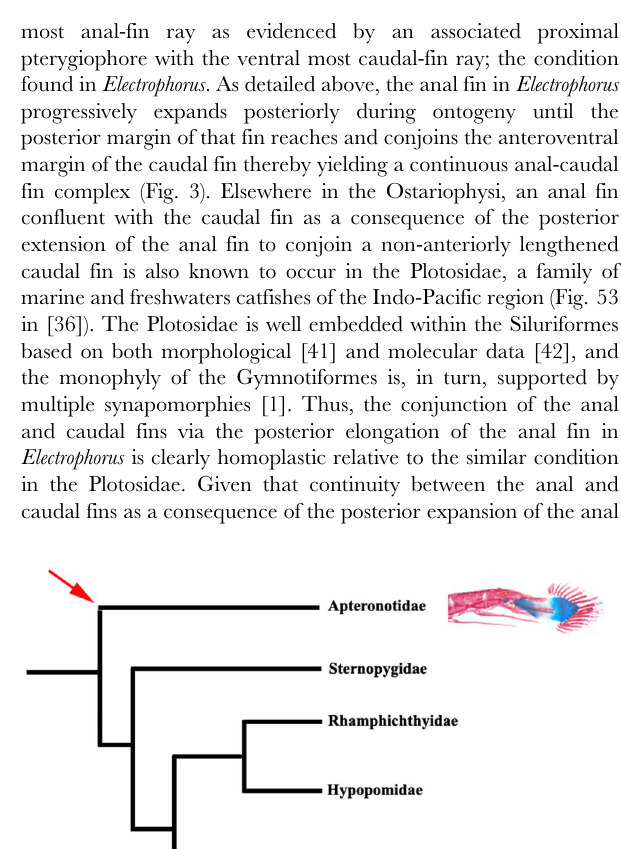
Figure 5. Photographic image of cleared and double stained caudal-fin region in Apteronotusrostratus , MBUCV 10926, 115 mm TL.